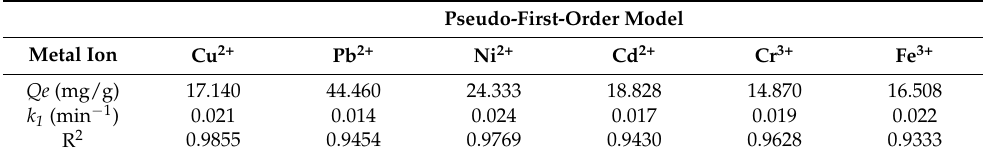
Table 4. Pseudo-second-order constants for adsorption of the MX+ onto MS .